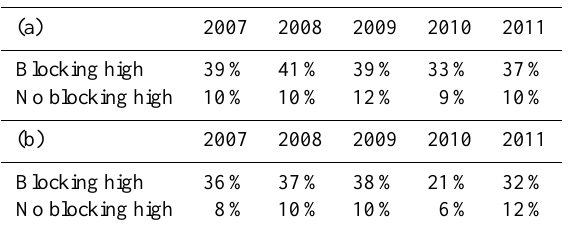
Table 3. (a) Probabilities of the simultaneous occurrence of PSCs at 15–20km and UCs at 9–11km in the presence and absence of blocking highs. (b) The same as (a) but for PSCs at 20–25km and UCs at